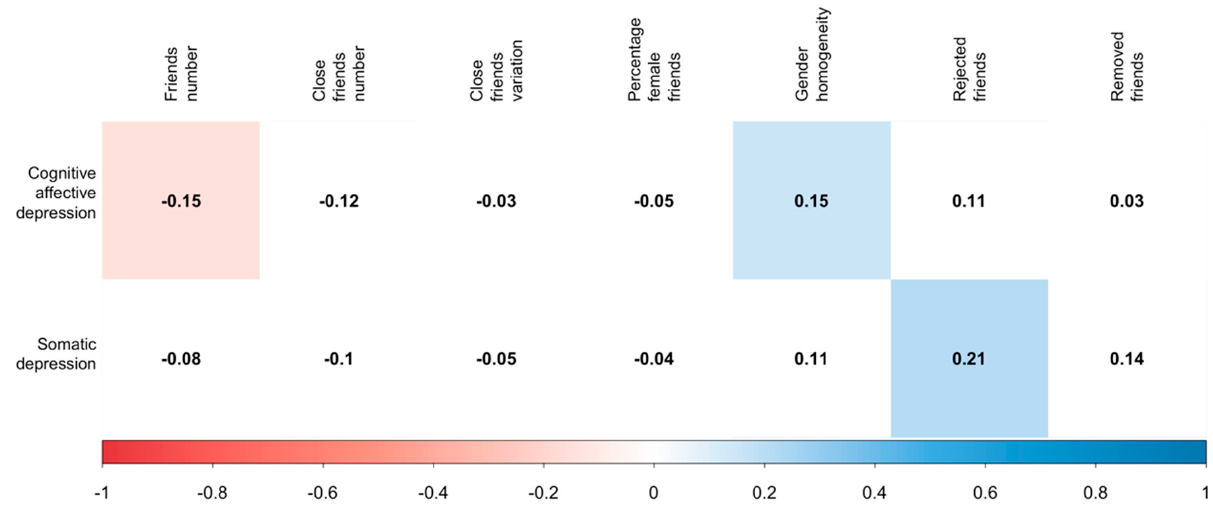
Figure 2. Pearson correlation between friendship network indicators and depression indicators.